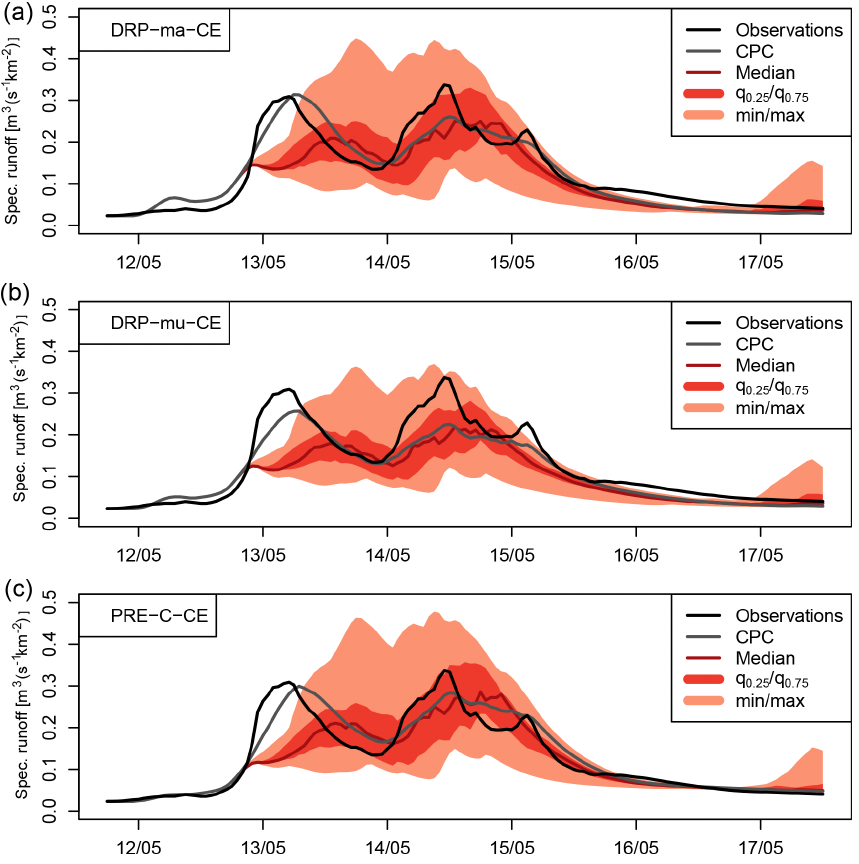
Figure 6. Probabilistic forecasts for the Emmenmatt catchment with a switch to the forecast mode on 12 May at 19:00 for (a) DRP-ma-CE, (b) DRP-mu-CE and (c)